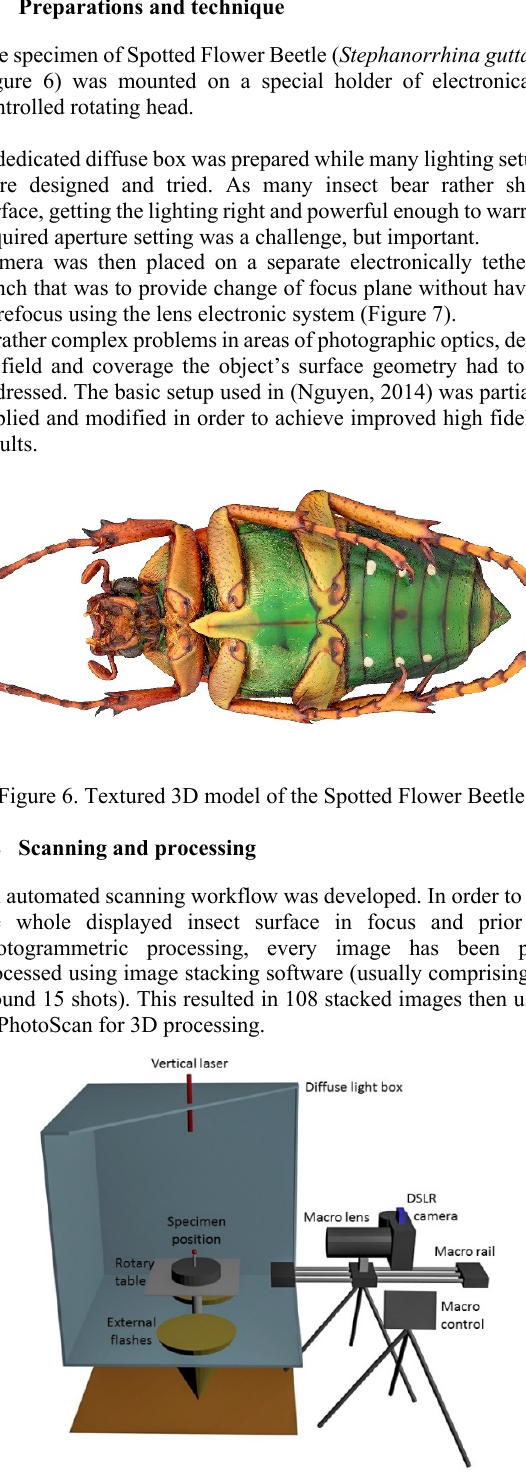
Figure 7. Schema of the macro scanning bench